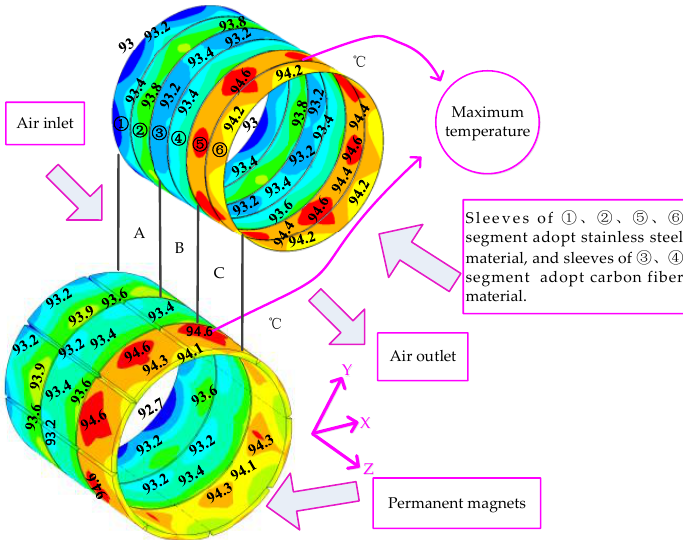
Figure 8. Temperature distribution of the permanent magnet and sleeve after applying the proposed permanent magnet local maximum temperature suppressing method.